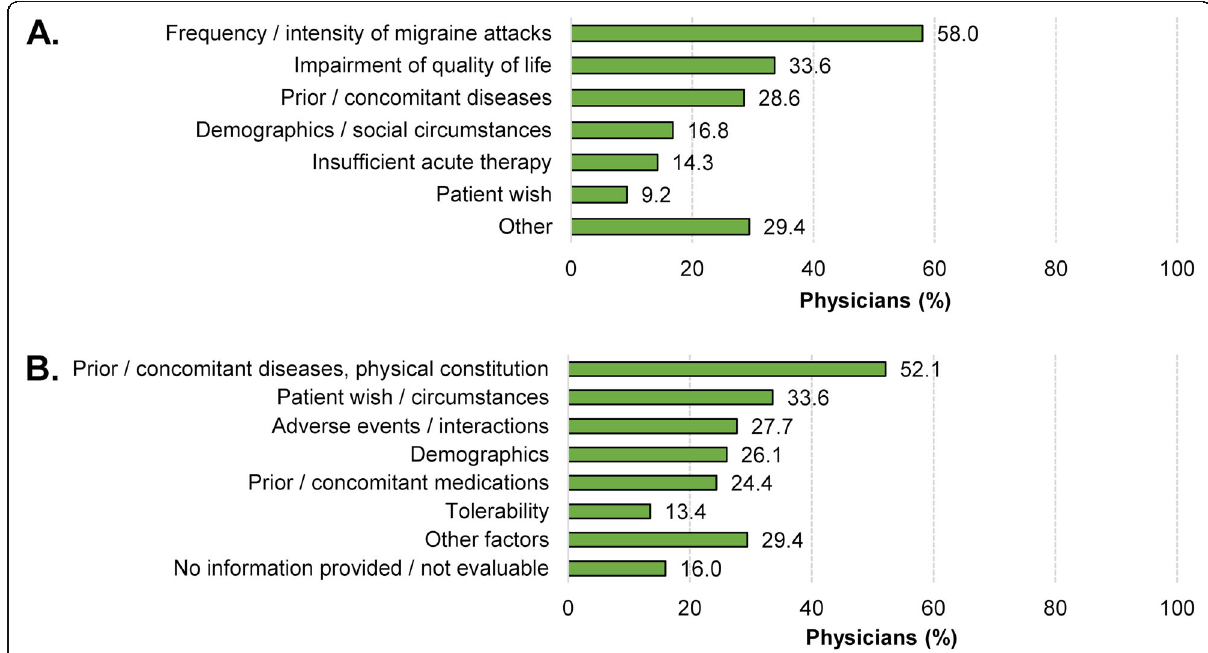
Fig. 4 [ A ] Reasons for prophylactic migraine treatment initiation (multiple answers allowed); [ B ] Reasons for prophylactic migraine treatment choice (multiple answers allowed) in